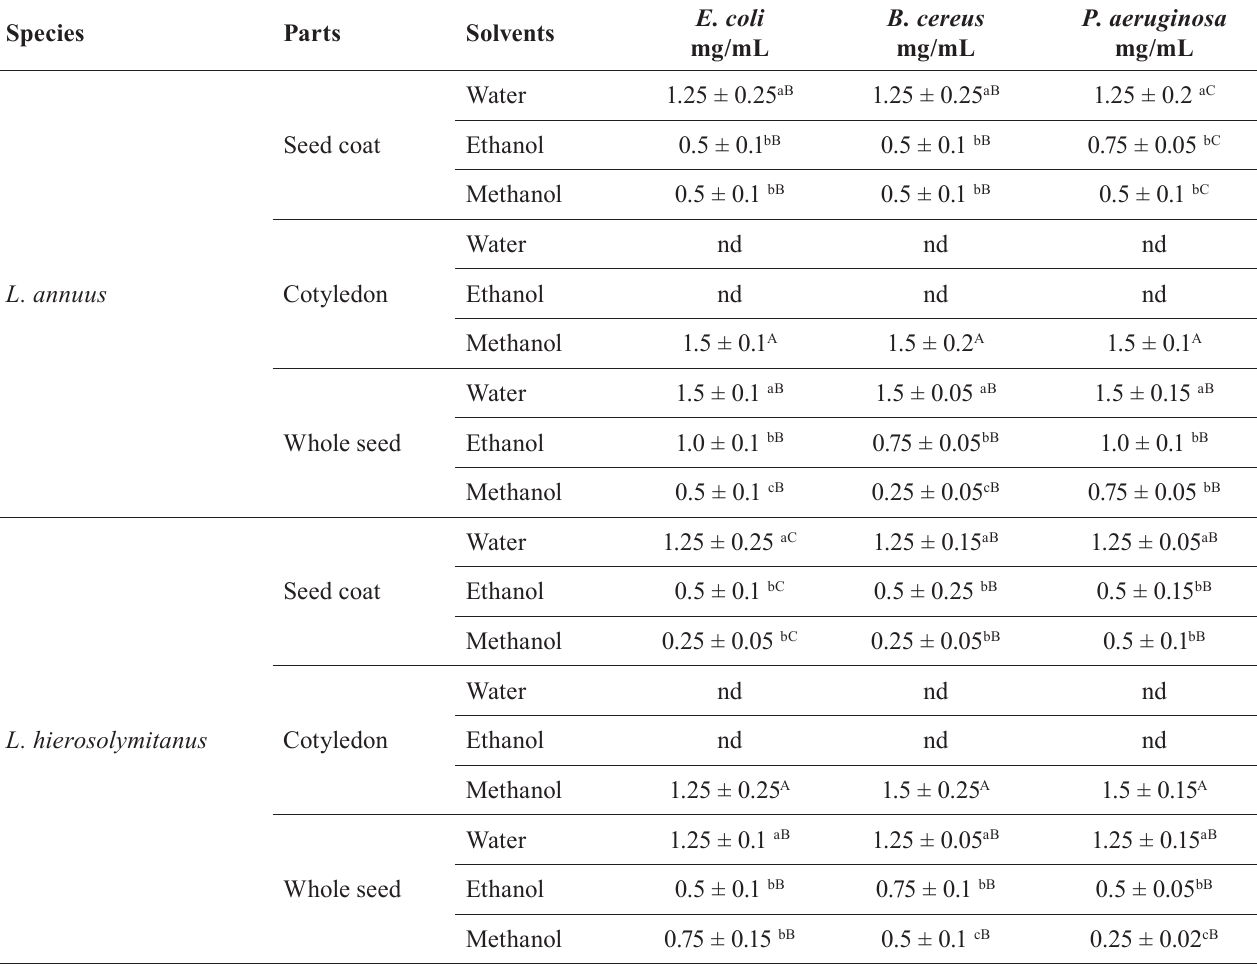
TABLE II - Minimum inhibitory concentrations of extracts from Lathyrus seeds on tested bacteria